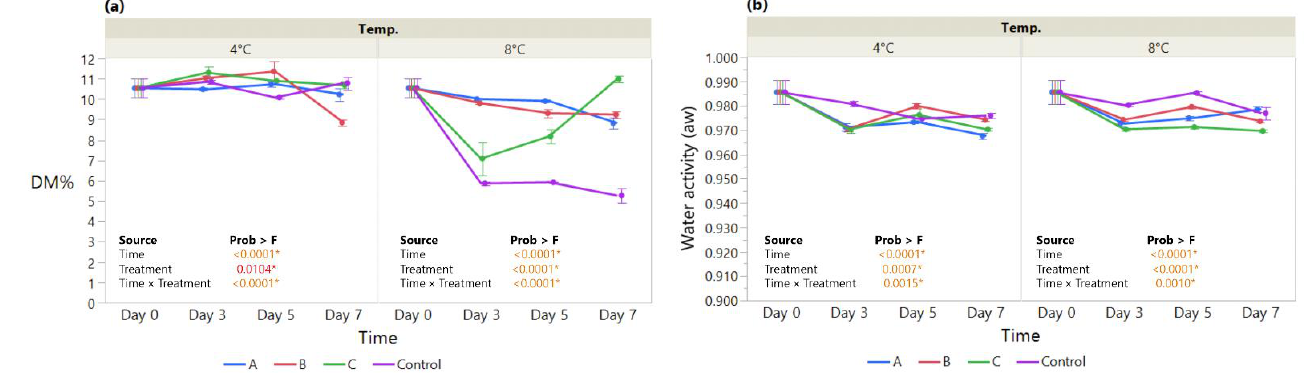
Figure 3. The effect of coating treatment on strawberry ( a ) Dry matter (DM%) and ( b ) Water activity (a w ) during a 7-day storage period at 4 °C and 8 °C. The p -values for the effects of Treatment (coating), Time and Interaction Treatment × Time are shown. Data are means ± SEM ( n = 3). Asterisk (*) indicates significance ( p < 0.05*).